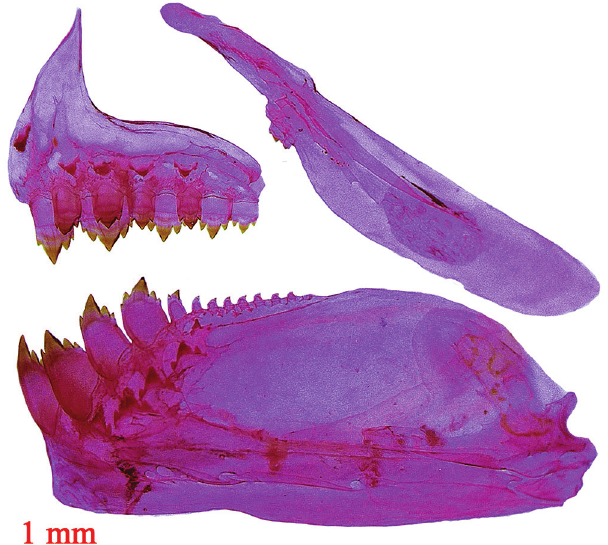
Fig. 2. Lateral view of left side of premaxilla, maxilla and dentary of Poptella actenolepis , MZUSP 122982, paratype, 63 mm SL.